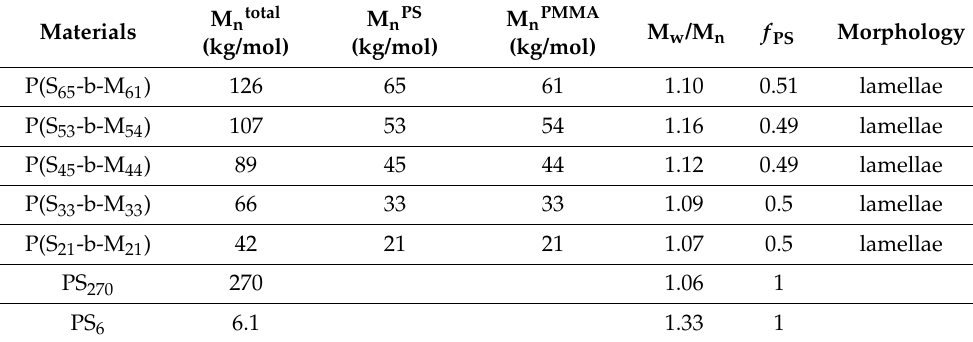
Table 1. Details of P(S- b -MMA) BCPs and PS